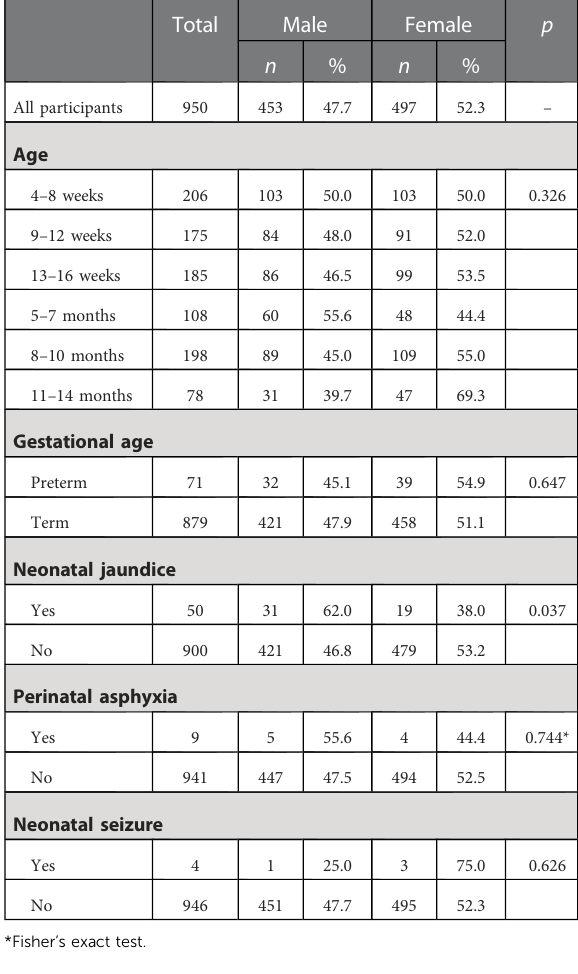
TABLE 1 Distribution of study Participants ’ characteristics by